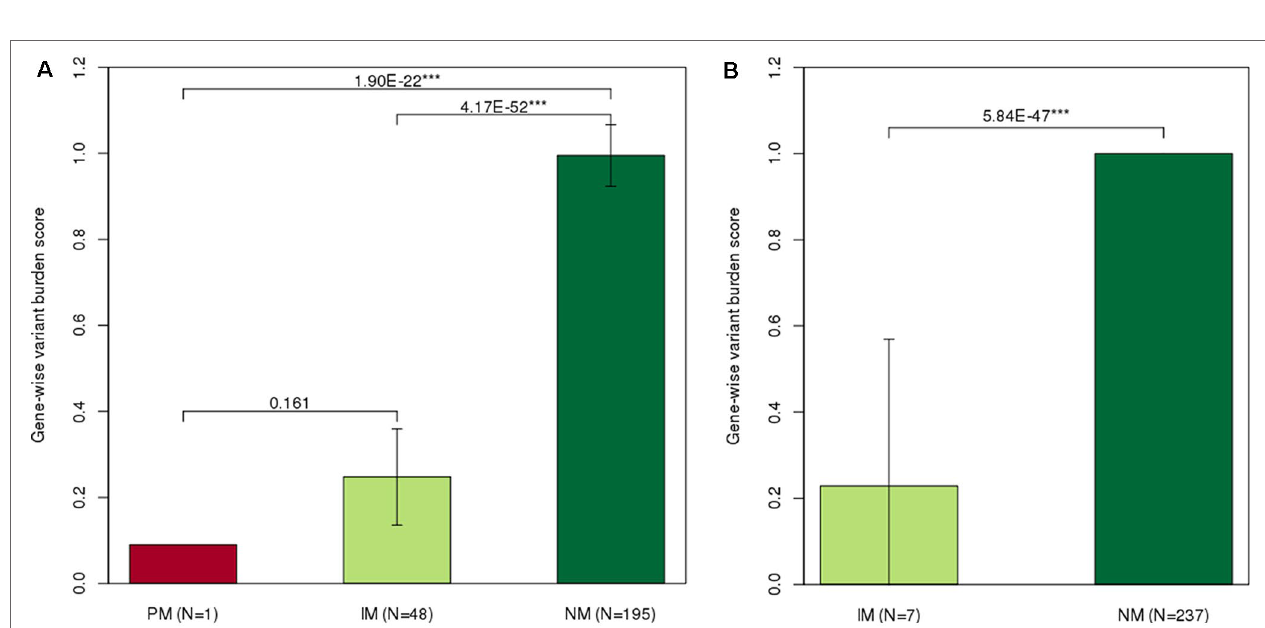
FIGURE 1 | Distribution of last-cycle dose intensity percent of 6-mercaptopurine according to star allele-based molecular phenotype groups in ALL. Dose intensity percent distribution across (A) Nudix Hydrolase 15 (NUDT15) and (B) Thiopurine S-Methyltransferase (TPMT) molecular phenotype groups. Normal metabolizers of NUDT15 showed significantly higher dose intensity percent than did intermediate ( p = 0.006) and poor ( p = 0.090) metabolizers. * p < 0.1, ** p < 0.05, and *** p < 0.01 by Mann–Whitney U test.